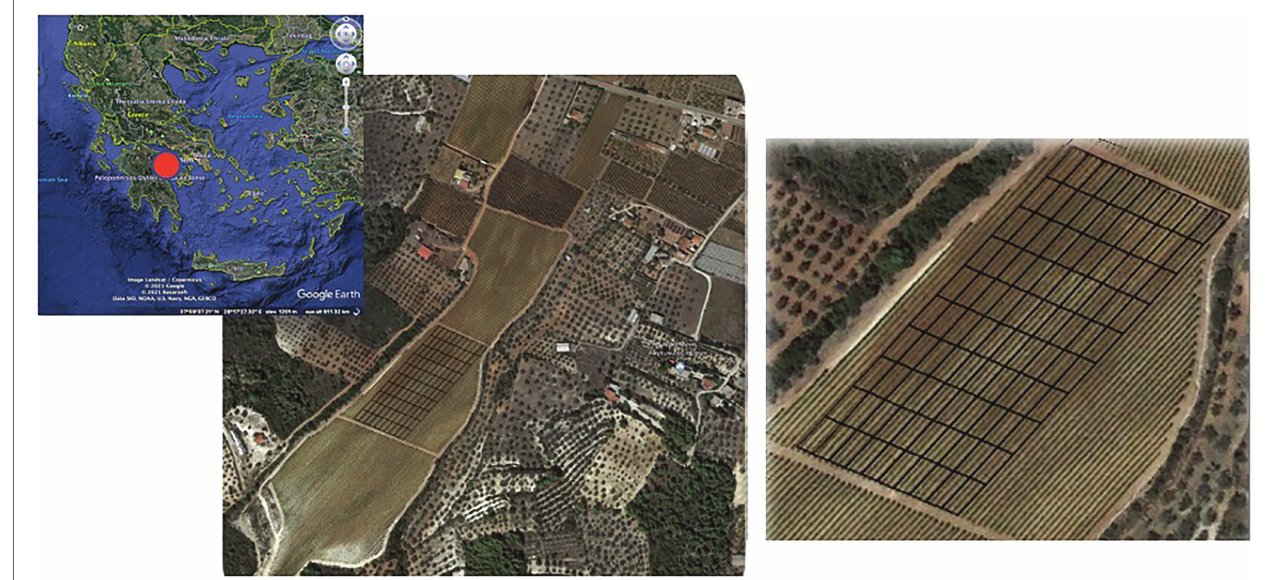
FIGURE 2 | Satellite images of the wine grapes commercial vineyard and the 100-cell grid developed parallel to the trellis lines (Google Earth Pro,